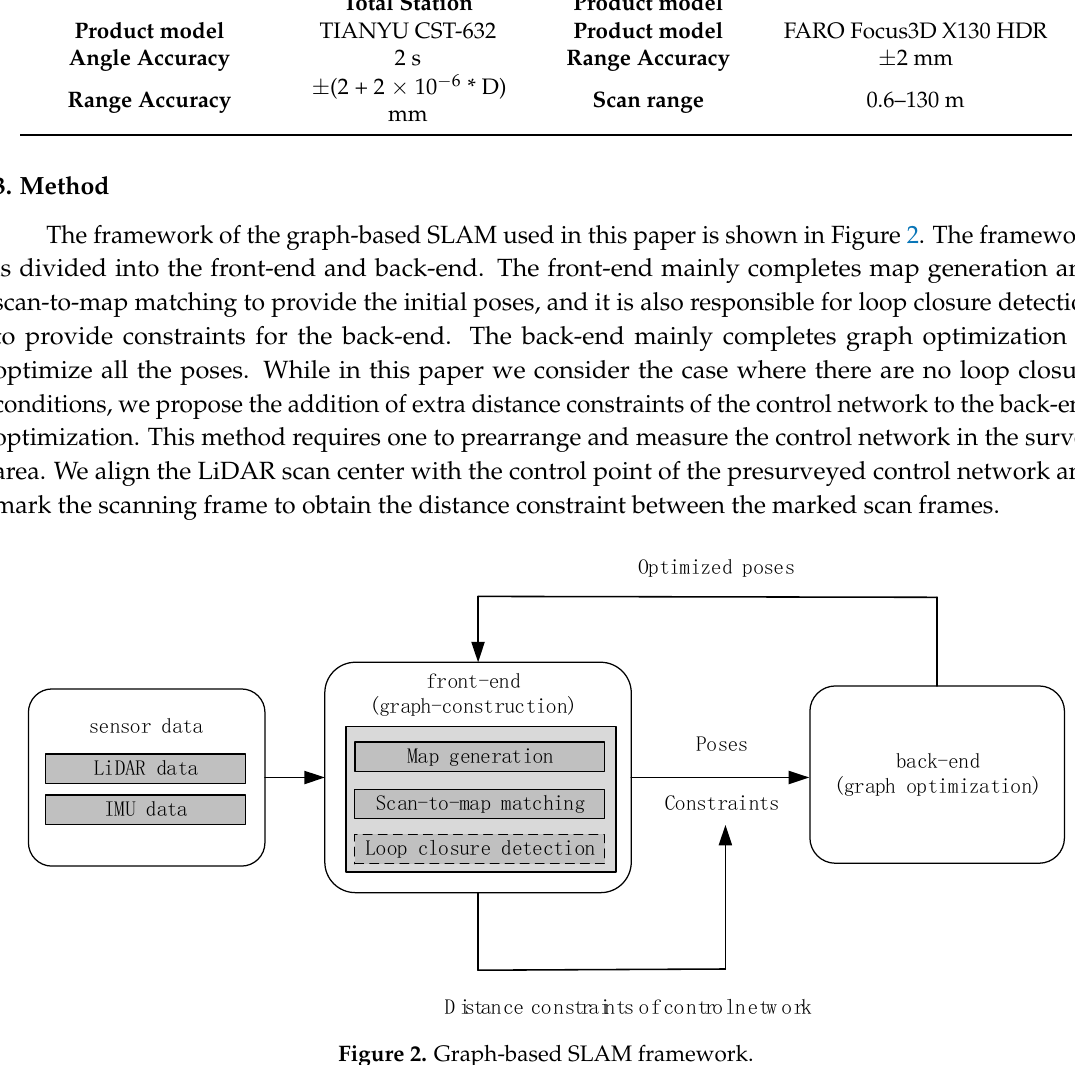
Figure 2. Graph-based SLAM framework.